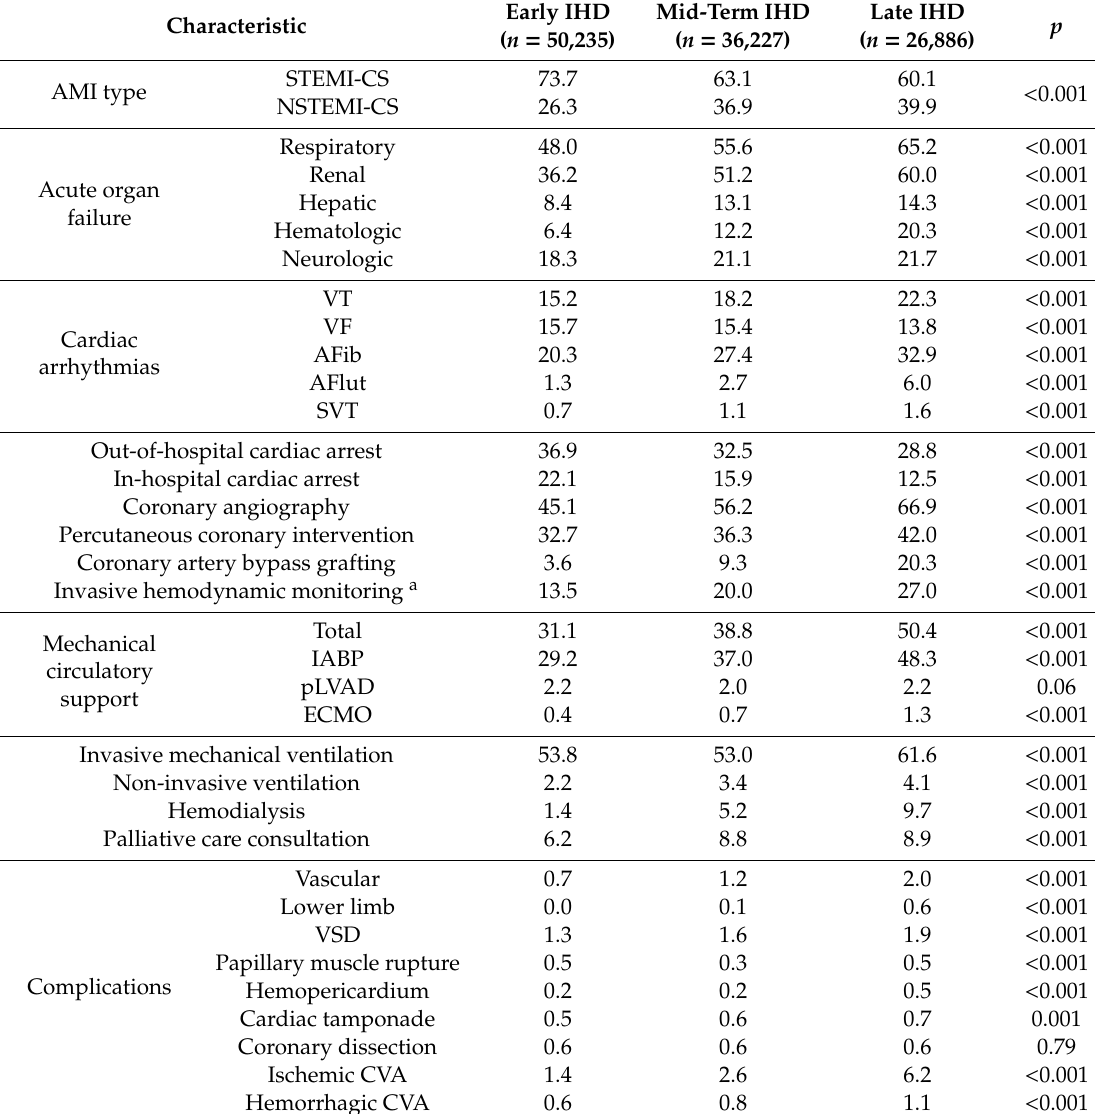
Table 2. Clinical characteristics of AMI-CS stratified by the timing of